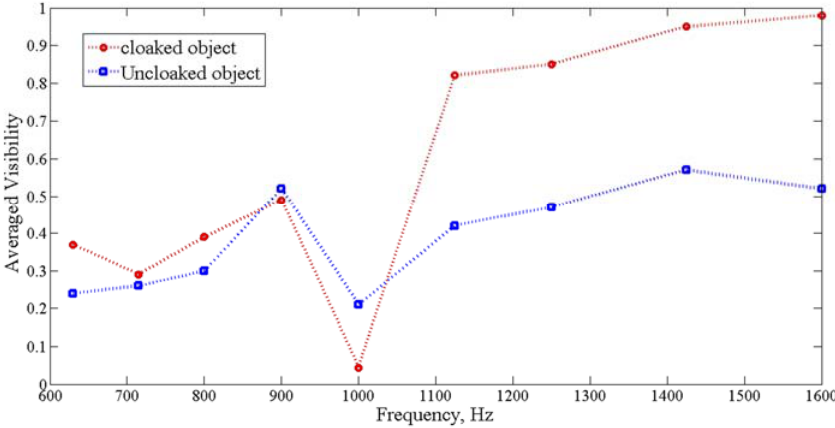
Figure 17. Average visibility values in cases of the cloaked object and the uncloaked object at frequencies from 630 Hz, 715 Hz, 800 Hz, 900 Hz, 1000 Hz, 1125 Hz, 1250 Hz, 1425 Hz, and 1600 Hz.